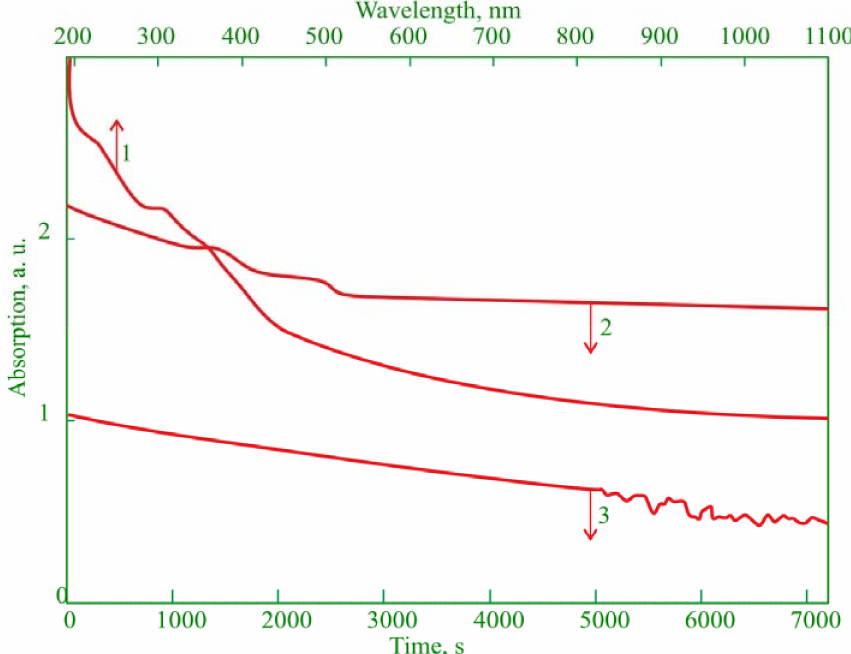
Figure 8. Colloidal stability of GF/TPO NP samples. Time-dependent changes in light absorbance of nanoparticle suspensions at a wavelength of 300 nm over the period of 2 h were determined. (1) absorption spectrum of the native GF/TPO NPs; (2) time-dependent changes in the absorbance of native GF/TPO NP suspension at λ = 300 nm over 2 h; (3) time-dependent changes in the absorbance of ICG-modified GF/TPO NP suspension at λ = 300 nm over 2